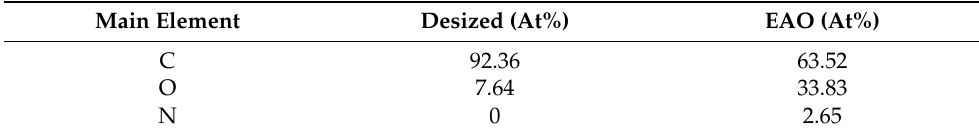
Table 1. Main elemental contents of CFs before and after EAO treatment. Main Element Desized